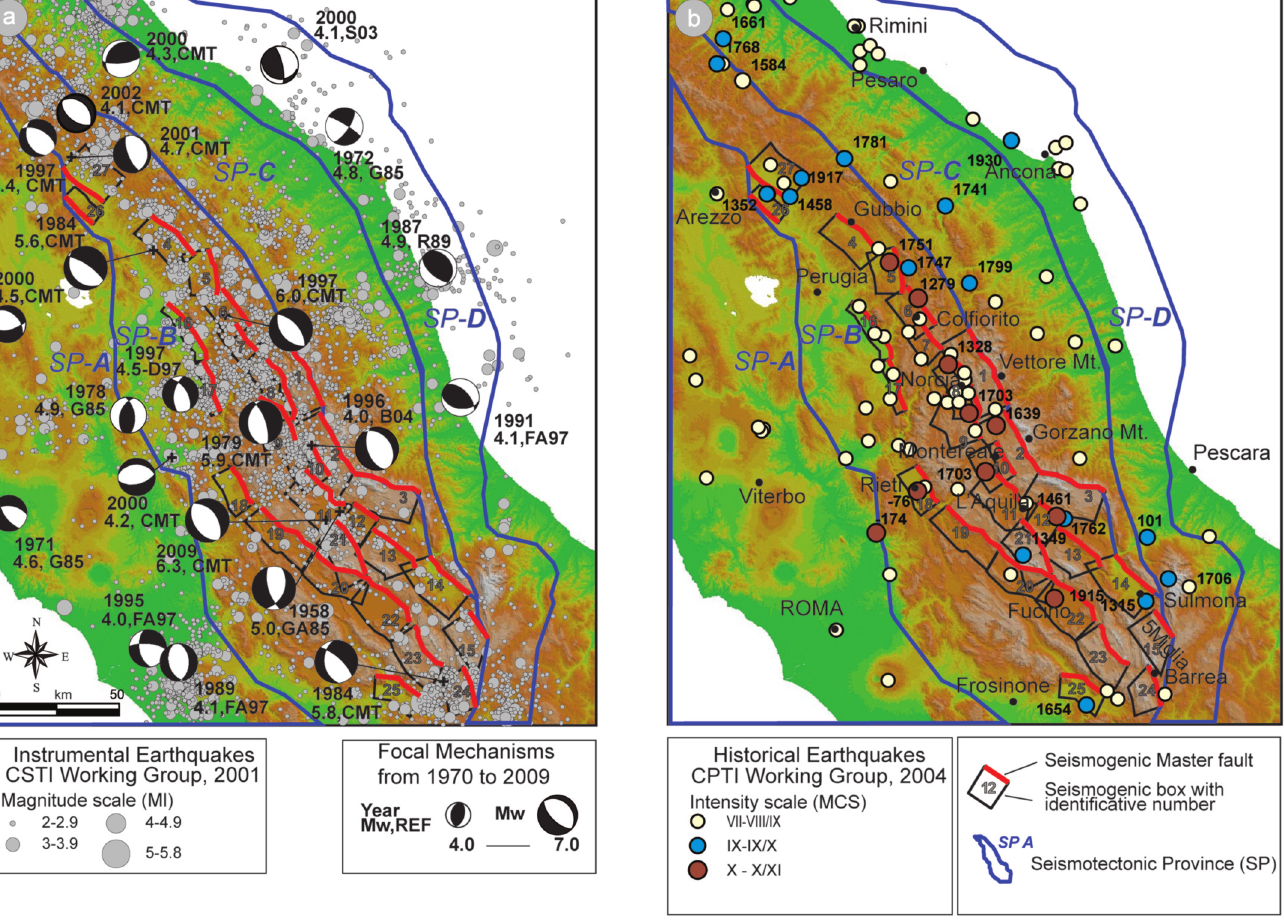
Figure 1. Layered seismogenic source model in central Italy. (a) Map of the SP and SB sources, of instrumental seismicity (CSTI) [CSTI Working Group 2001] and focal mechanisms of the main events; the source codes are as follows: G85, Gasperini et al. [1985], R89, Riguzzi et al. [1989], FA97, Frepoli and Amato [1997], D97, Di Luccio et al. [1997], S03, Santini [2003], B04, Boncio et al. [2004], CMT, catalog at www.seismology.harvard.edu and MedNet regional at www.mednet.ingv.it. The geometries were the same as those of Pace et al. [2006], except for the SBs near Arezzo (Città di Castello sources) [Brozzetti et al. 2009]; (b) Map of the SP and SB sources, and of historical seismicity (CPTI) [CPTI Working Group